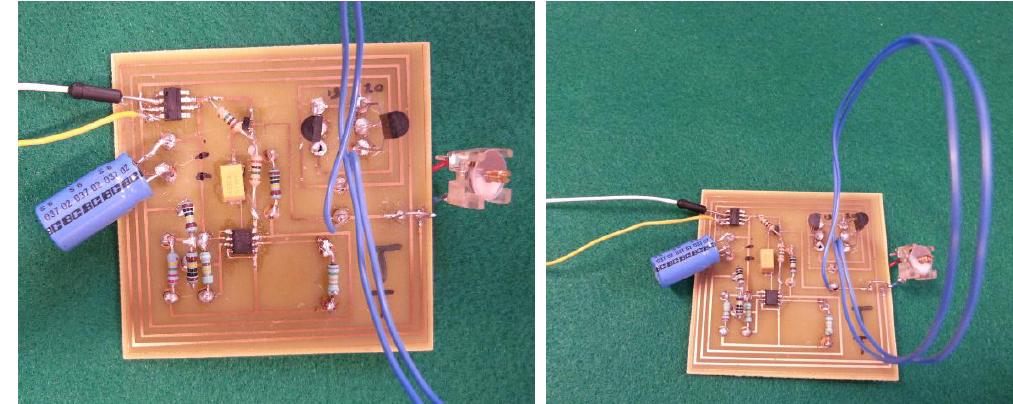
Figure 25. Layout of the power management unit and the capacitive sensor read-out circuitry (65 × 65 mm 2